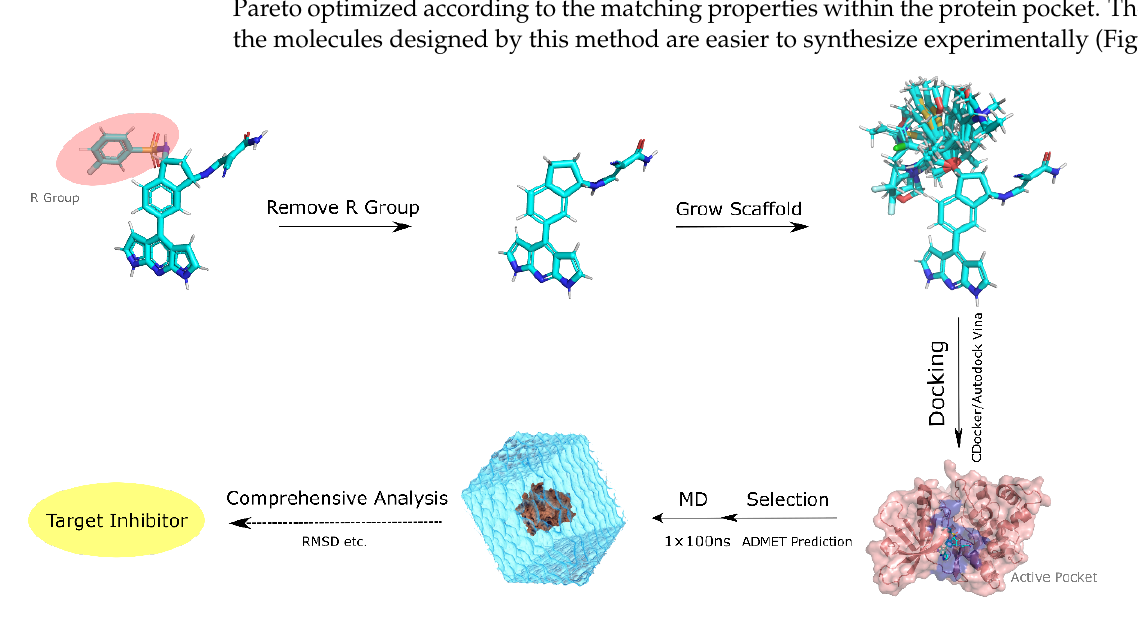
Figure 8. The flow chart describes the study to generate 1,7−dihydro−dipyrrolo [2,3−b:3′,2′−e] pyridine as the core inhibitor and screen the targeted inhibitor workflow.